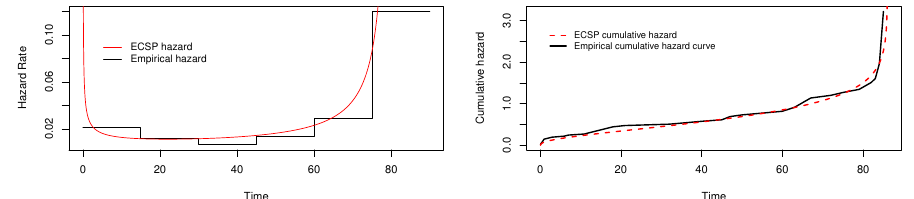
Figure 13. Plots of the empirical and estimated hrf, and the empirical and estimated chrf of the ECSP model for real data